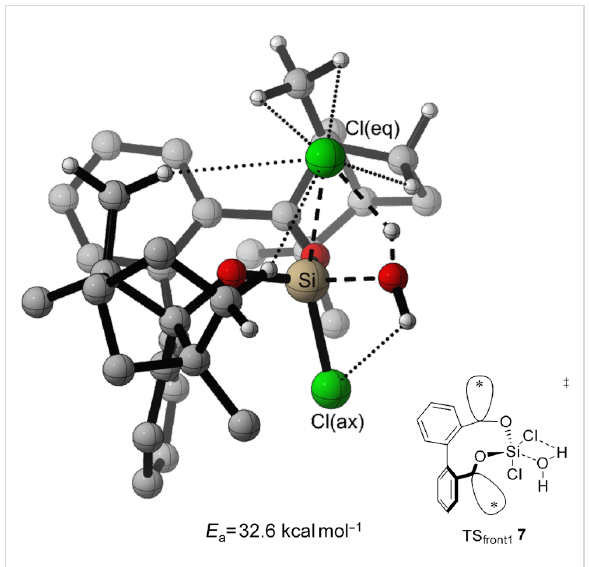
Figure 6: Transition state leading to 8 eq following front1 attack ( E a = 32.6 kcal mol − 1 , Figure 5, Table 3, entry 1). Breaking and forming bonds in dashed lines, additional C–H-interactions with dotted lines (M06-2X-D3/6-311++G(d,p)(PCM=THF)//B3LYP-D3BJ/6-31G(d) at 298 K).